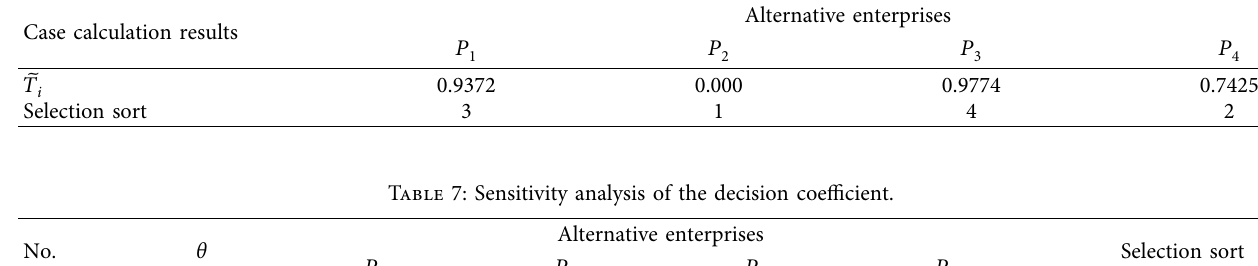
Table 6: Evaluation results.